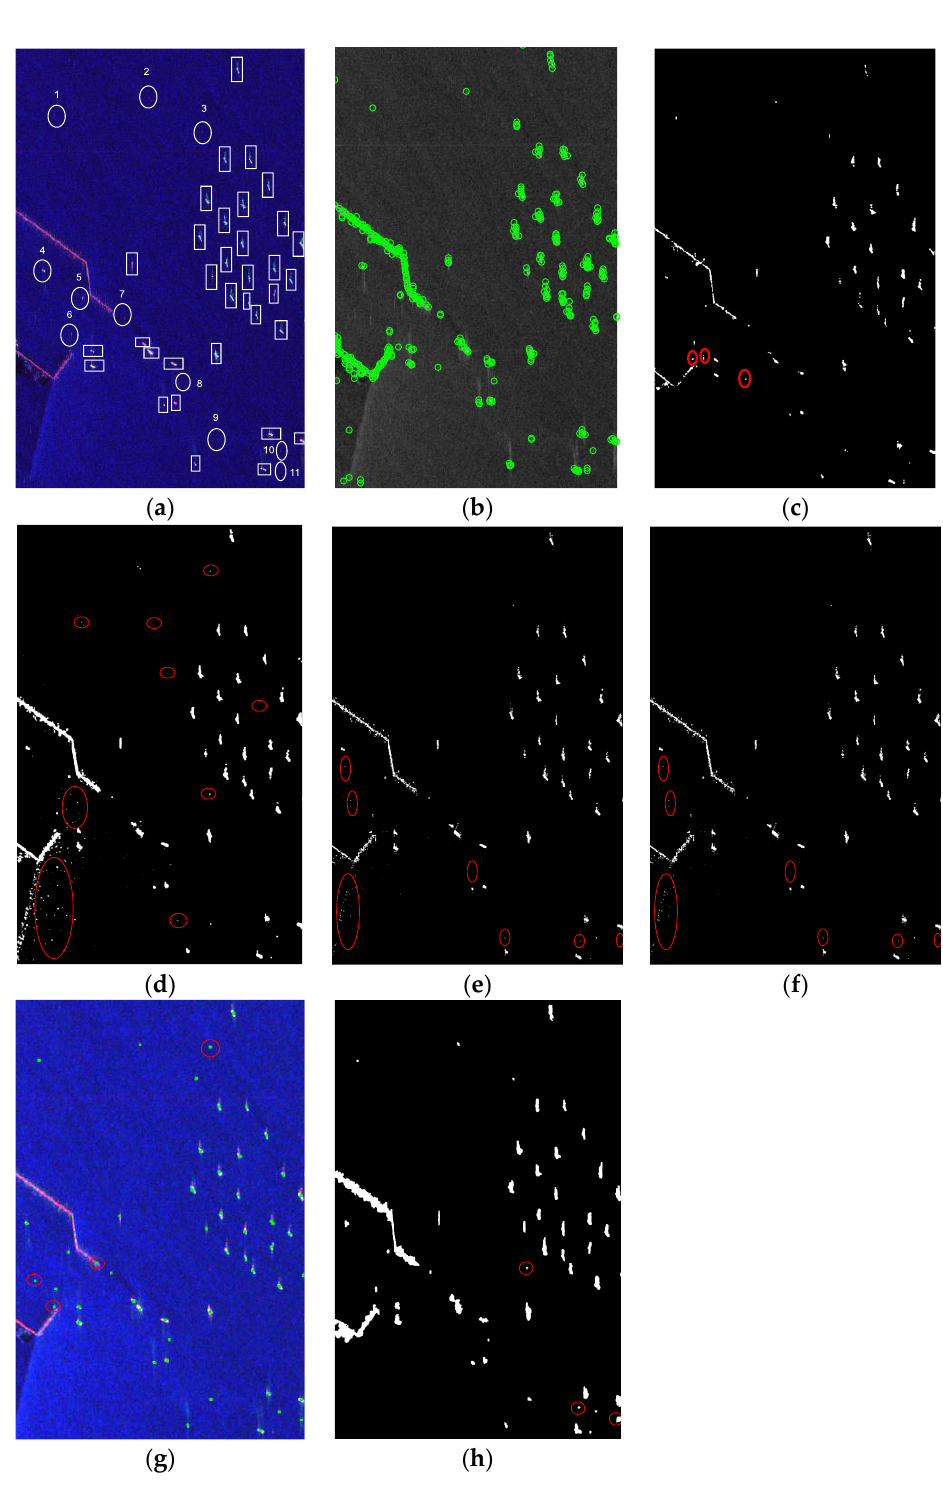
Figure 11. R3 regions: ( a ) Pauli pseudo-color image with potential targets manually marked. White rectangles indicate the strong targets and white ellipses indicate the comparatively weak targets. ( b ) Keypoints extracted by PolSAR-SIFT keypoint detector. ( c – h ) Detection results of the proposed method, the PNF, the PWF, the RS, the SD-LSMDRK and the SD-SLLIM, respectively. The main false alarms are marked by the red circles.